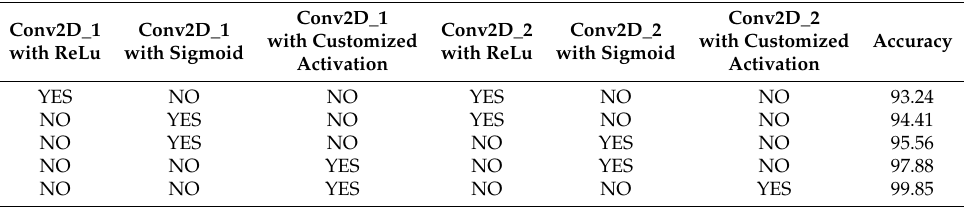
Table 10. Ablation study of the proposed